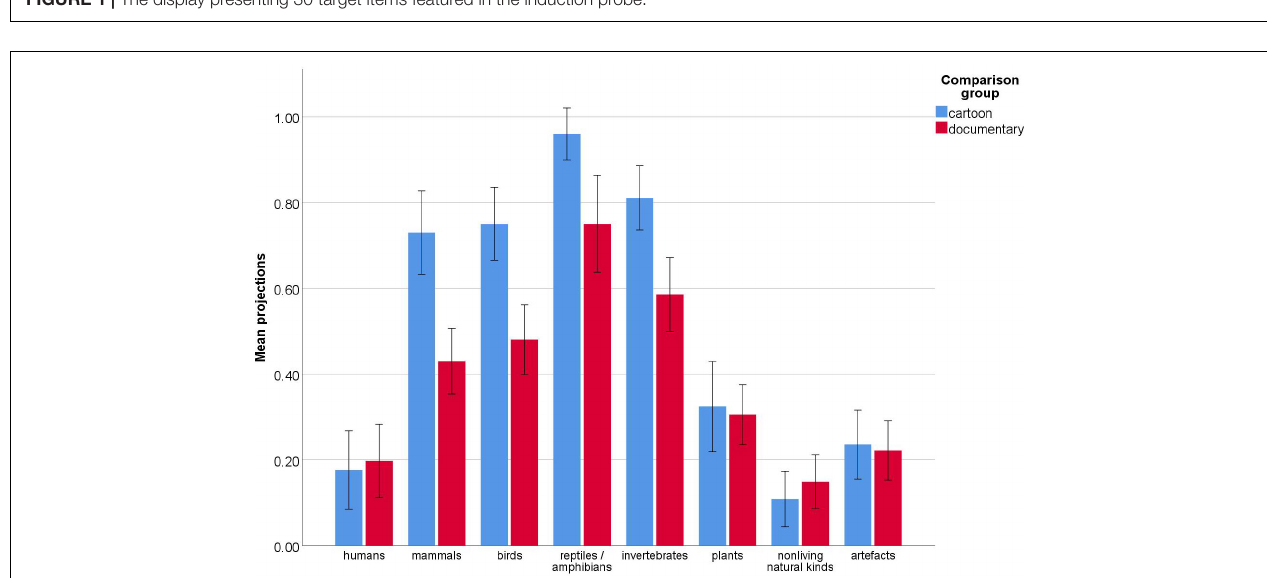
FIGURE 2 | Proportions of attributions of axons by target category and comparison group. Error bars represent 95% confidence intervals adjusted for repeated measures.